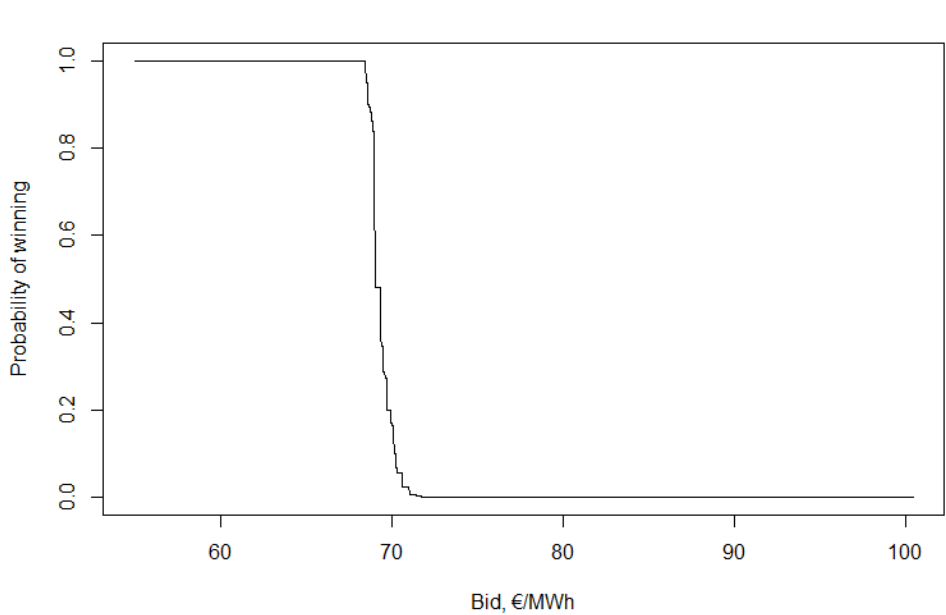
Figure A10. Probability of winning in case of different bids, assuming F 4 bid distribution, source: own